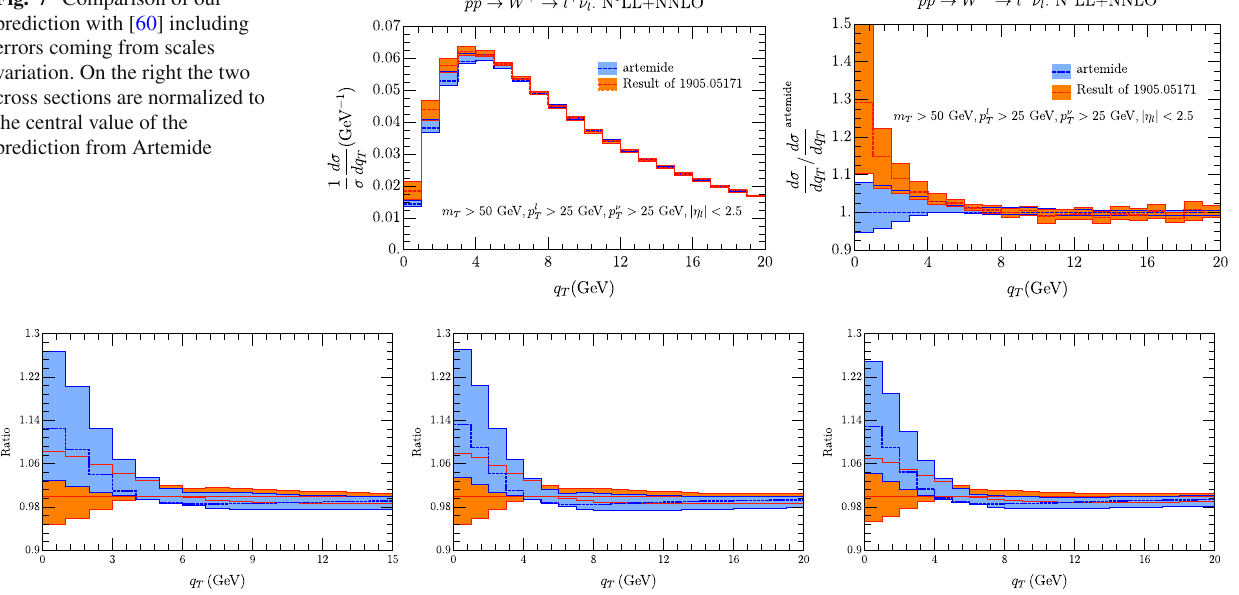
Fig. 8 Ratio of W + cross section without λ i non-perturbative effects over the same cross section with the full model (blue band). The scale errors are shown by the bands. The orange band is ratio of the cross section in the full model over itself, and scale error band is also